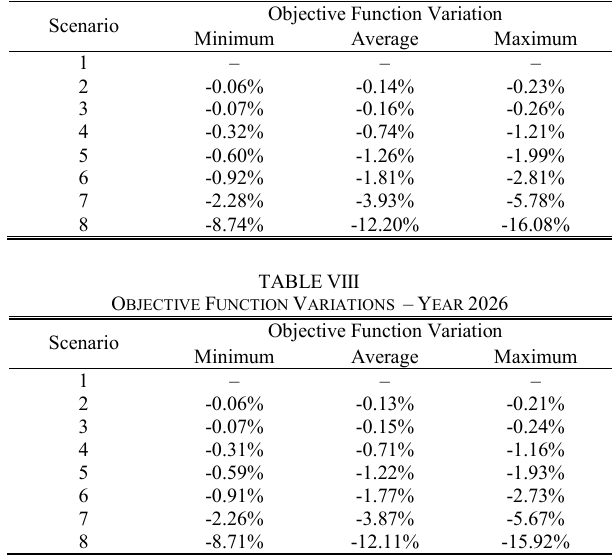
TABLE VII O BJECTIVE F UNCTION V ARIATIONS – Y EAR 2016